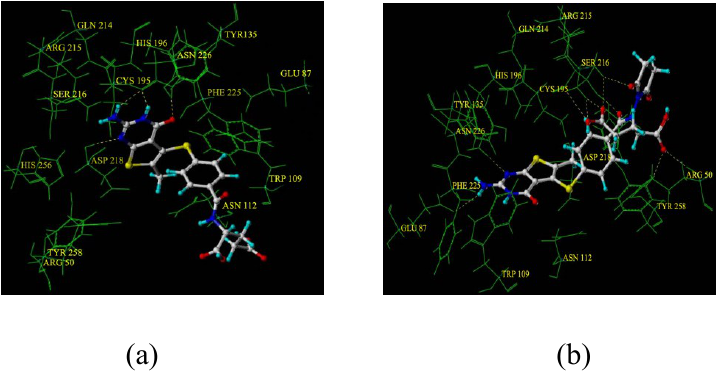
Figure 9: (a) Dockpose of molecule 1 (b) Dockpose of designed molecule (New 2).